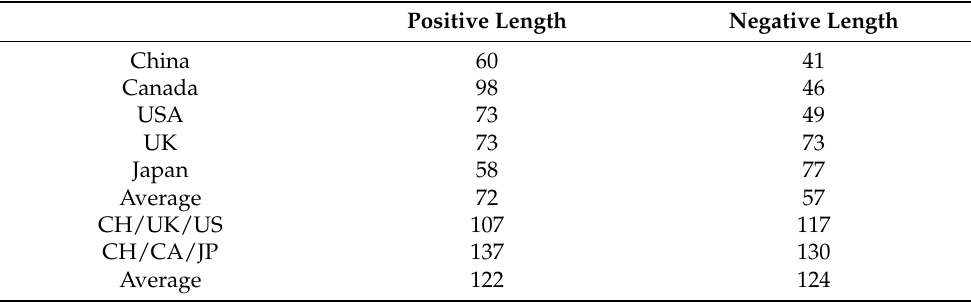
Table 2. 2019–1999 years’ gold price in USD to stock index correlation